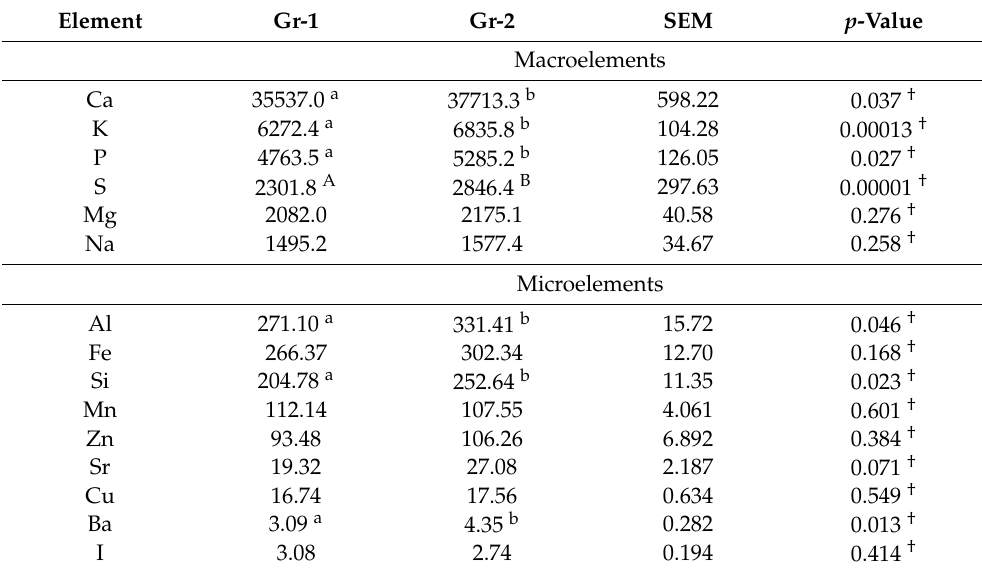
Table 3. The concentrations of macro- and microelements in the feed mixture (mg/kg).